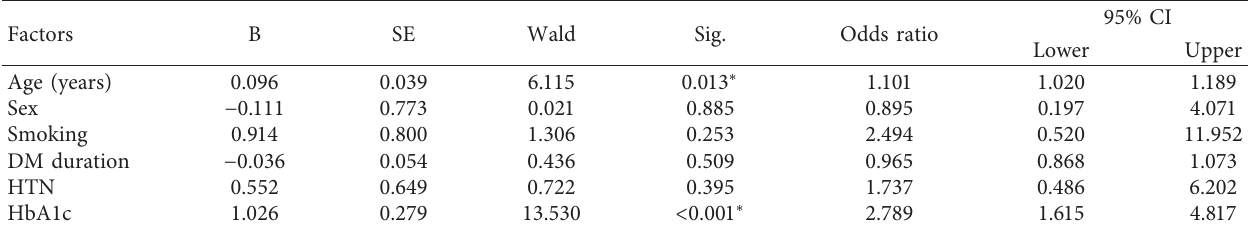
Table 4: Logistic regression analysis of factors affected the RBDSQ in diabetic patients and control